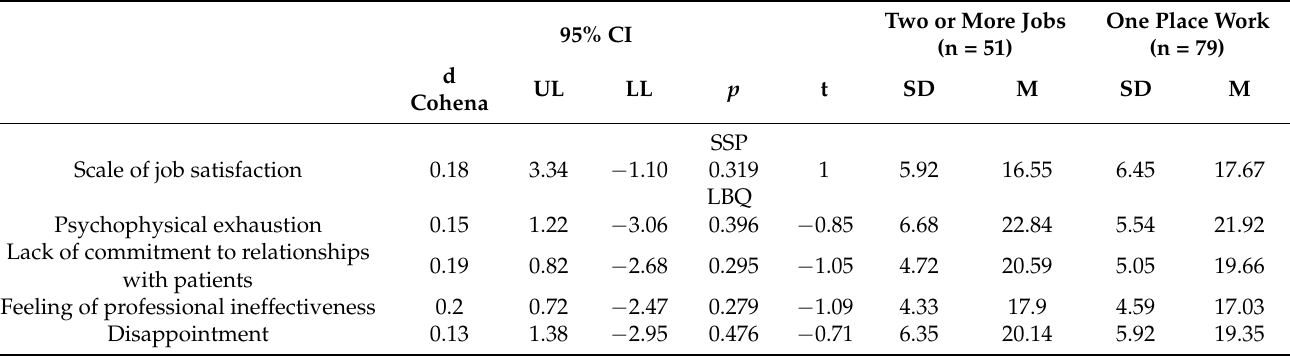
Table 3. Differences in job satisfaction and burnout depending on the number of jobs.